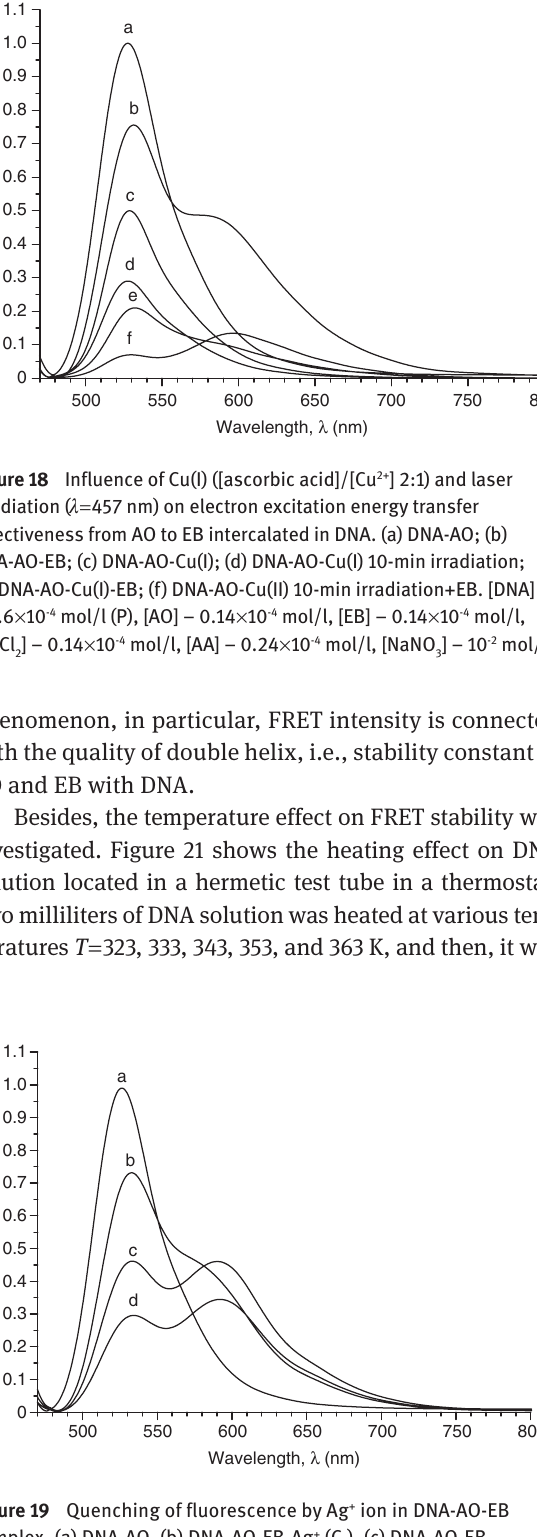
Figure 19 Quenching of fluorescence by Ag + ion in DNA-AO-EB complex. (a) DNA-AO, (b) DNA-AO-EB-Ag + (C ), (c) DNA-AO-EB- 1 Ag + (C ), (d) DNA-AO-EB-Ag + (C ). [DNA] – 2.8 × 10 -4 mol/l (P), [AO] 2 3 – 0.14·10 -4 mol/l, [EB] – 0.14 × 10 -4 mol/l, [Ag + ] – 0 (C ), [Ag + ] 1